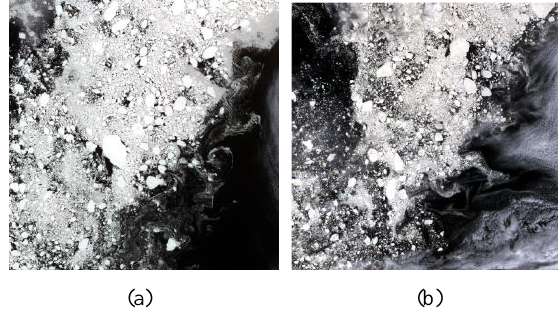
Fig.2 The pre-processed MERSI images recorded on (a) June 10, 2014, (b) July 14,